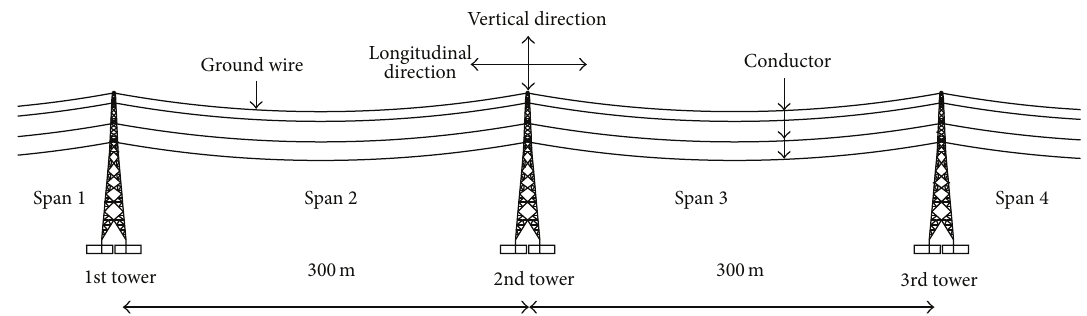
Figure 2: Three-dimensional finite element model of transmission tower-line system.